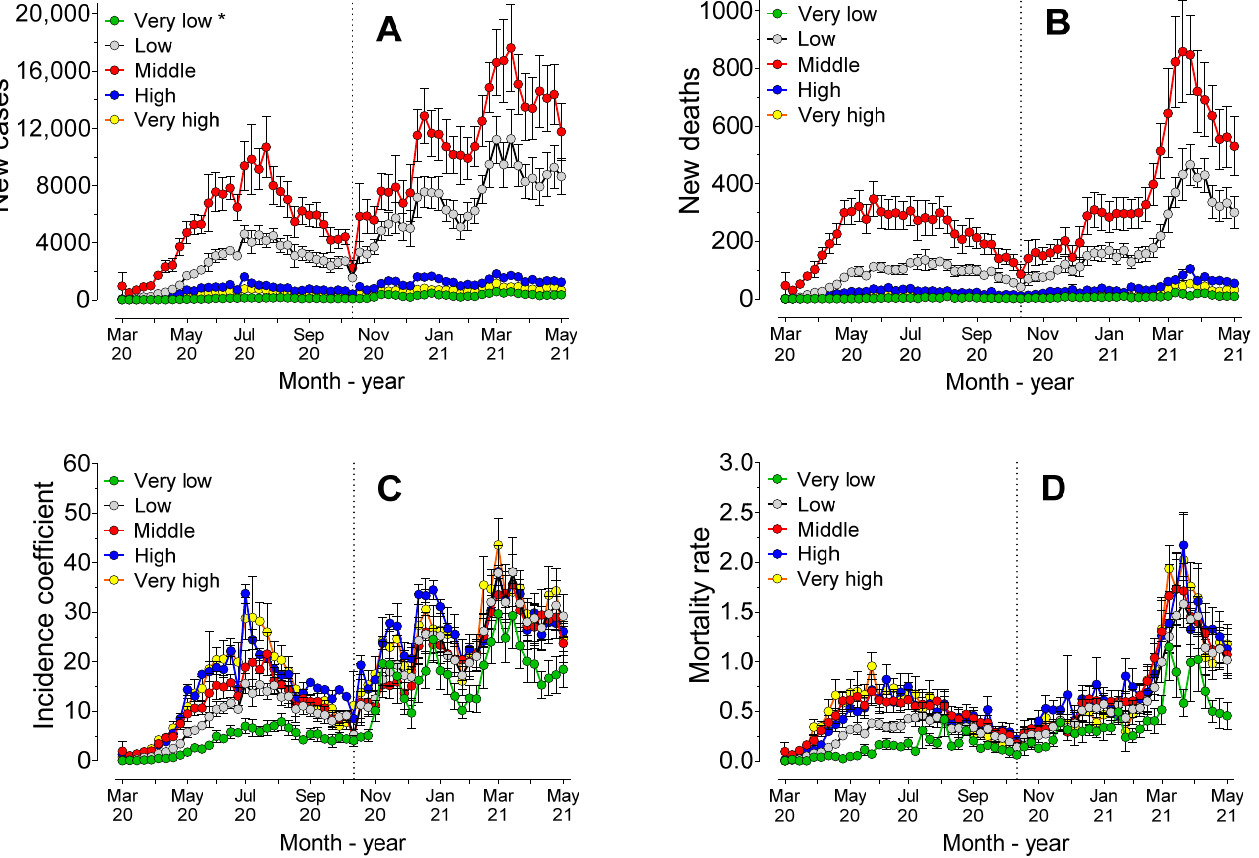
Figure 4. Mean (standard error) of cases ( A ) and new deaths ( B ), incidence coefficient ( C ) and mortality rate ( D ), over the course of 62 weeks of the pandemic, considering the gross domestic product (GDP) strata of the cities. * Very low GDP (lower than BRL 10,000); low GDP (BRL 10,001 to BRL 30,000); middle GDP (BRL 30,001 to 60,000); high GDP (BRL 60,001 to 100,000); and very high GDP (higher than BRL 100,000).